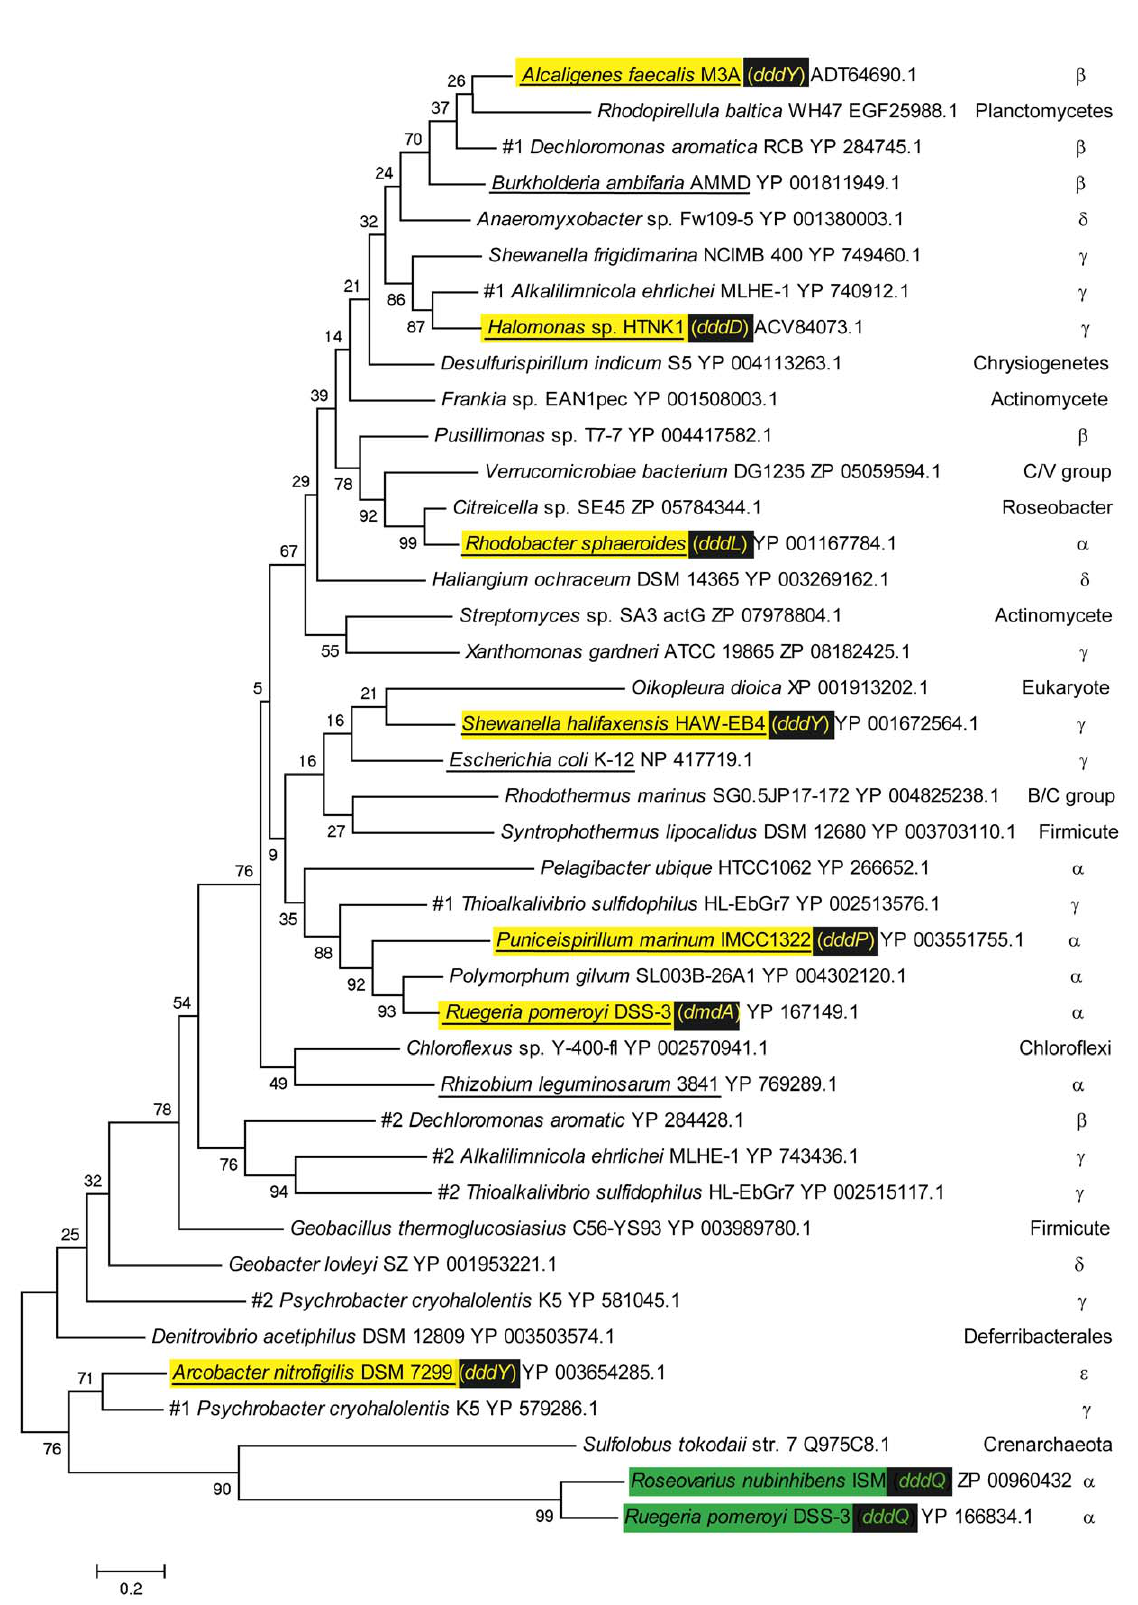
Figure 2. Molecular phylogenetic analysis of selected AcuI polypeptides. Strains, clades, and protein identification numbers of a selection of the AcuI polypeptides in are shown. Strains in which MDR012-type polypeptides are encoded by acuI genes that are close to dmdA or to the various ddd genes are highlighted in yellow and the two MDR028 gene products near dddQ in green. Those cases where the cloned acuI genes were shown experimentally to correct the acrylate sensitivity of the E. coli YhdH 2 mutant are underlined. Other examples illustrate the wide taxonomic range of